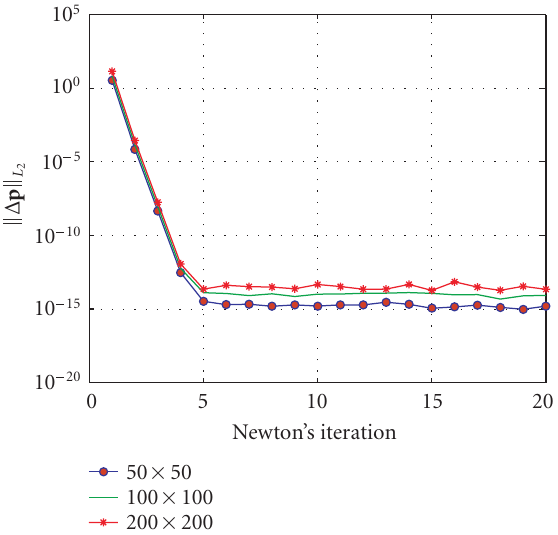
Figure 4.6 . Example 4.2: Newton’s iteration versus norm of the di ff erence vector (cid:4) Δ p (cid:4) L meshes.